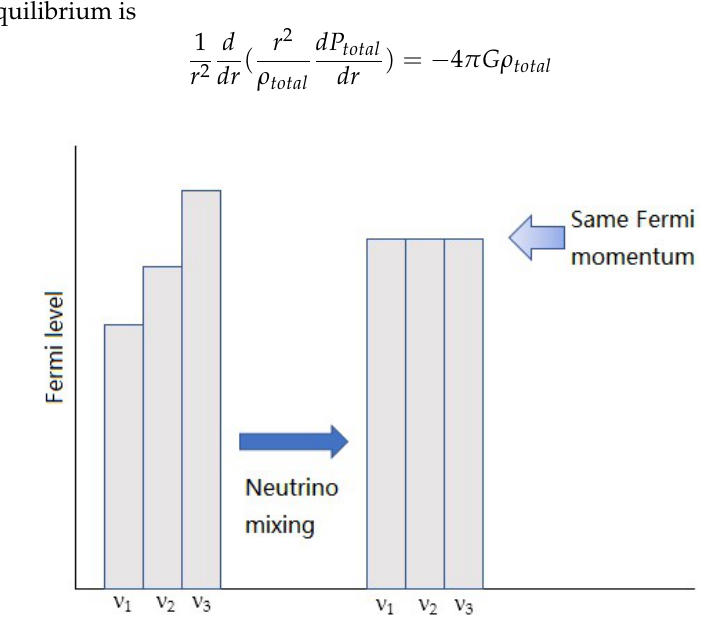
Figure 2. Neutrino flavor mixing for condensed neutrinos.